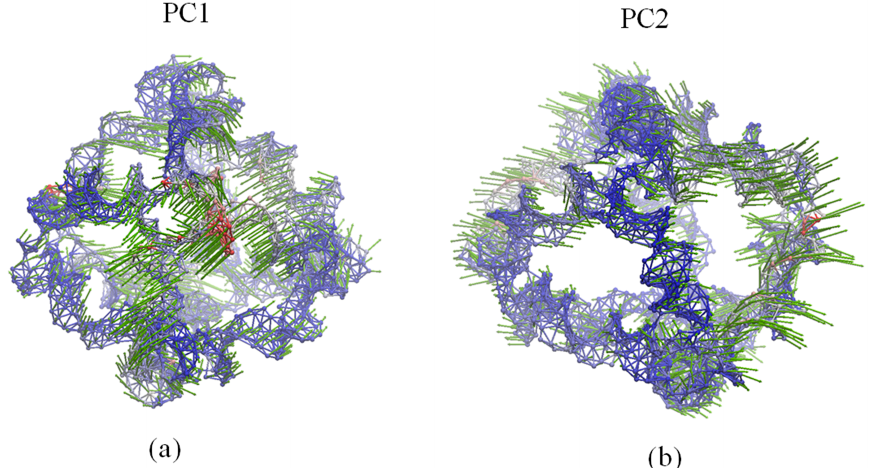
Figure 4. Dynamical motions predicted by: ( a ) PC1 and ( b ) PC2. Network representation of the DNA octahedron. Red and blue colors denote regions with high and low fluctuations, respectively, while arrows (green) denote the direction of the motions.